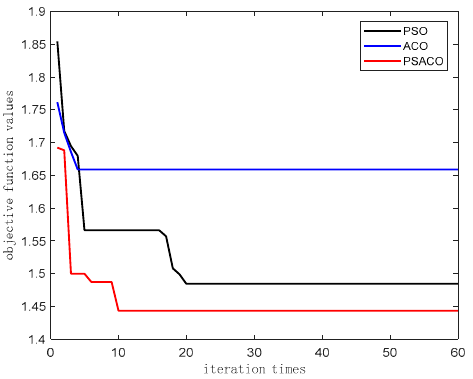
Figure 9. Iterative process diagrams of PSACO.